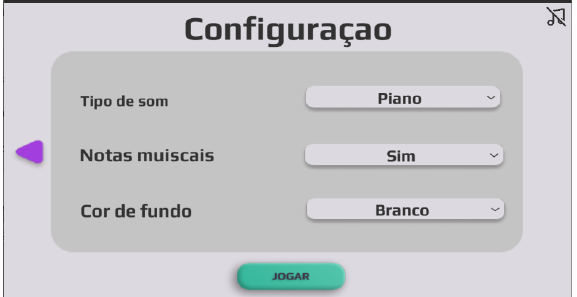
Figure 11. Ritmo Mania settings